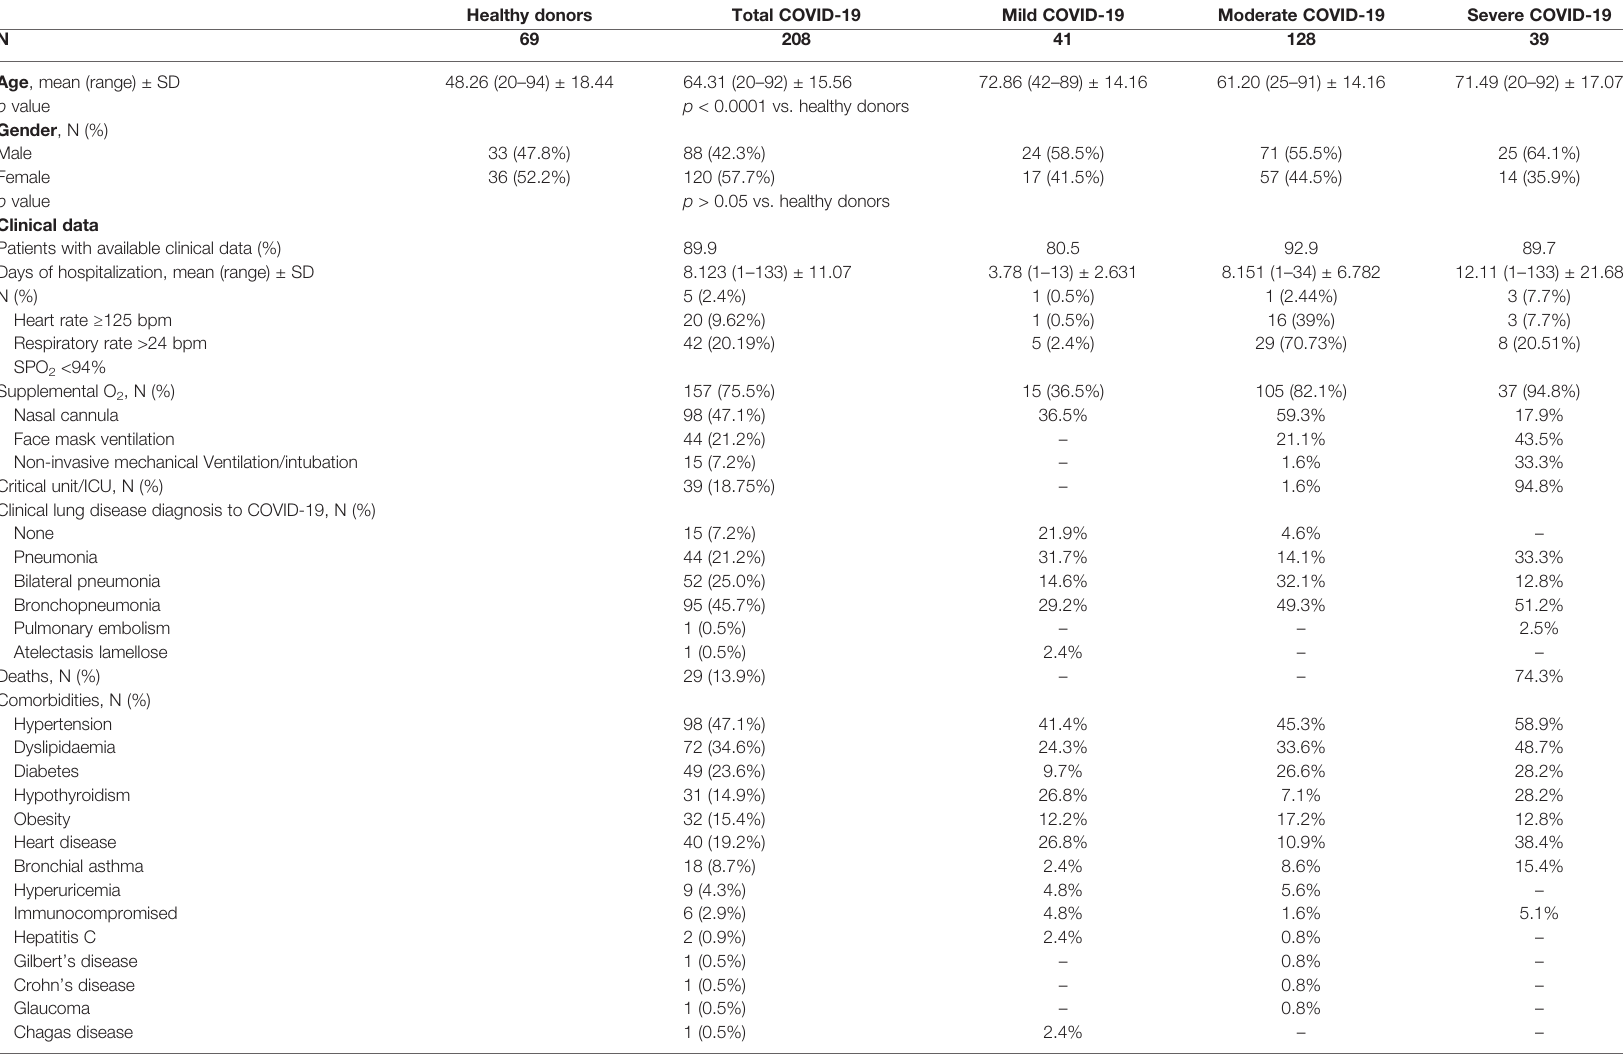
TABLE 1 | Demographic and clinical characteristics of the individuals included in this